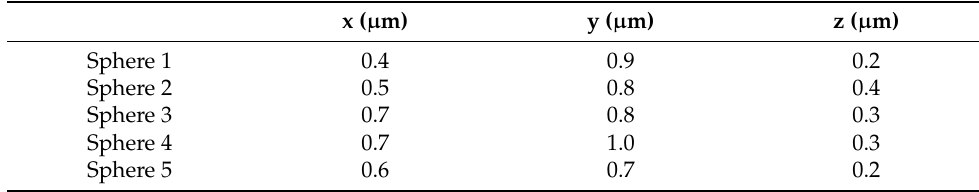
Table 3. The sphere diameter deviations.